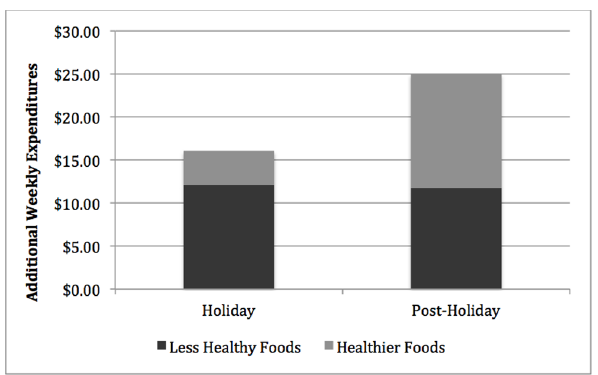
Figure 2. Households Increase the Purchase of Healthier Foods After the Holidays. Additional expenditures were calculated by subtracting expenditures in the holiday and post-holiday seasons from baseline expenditures. Additional expenditures for the less healthy and healthier items were stacked to show total additional expenditures in the respective